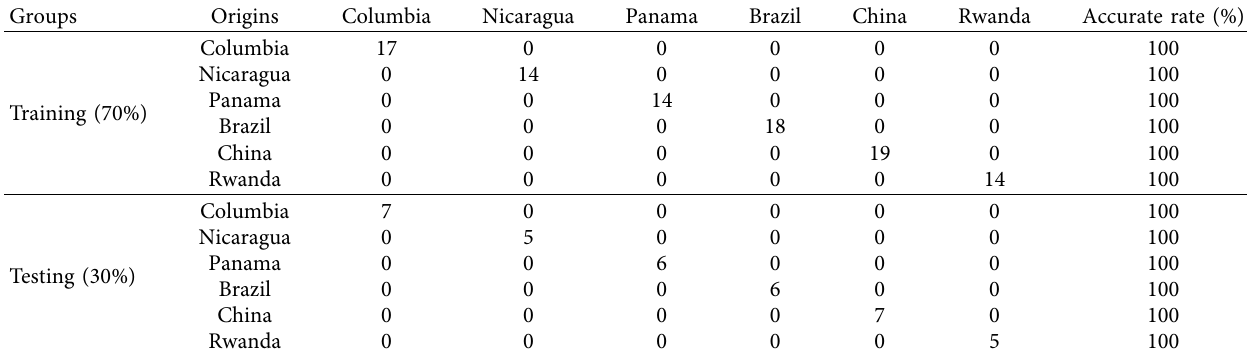
Table 9: Classifcation of 131 dark roasted beans from six diferent original regions by RF model. Groups